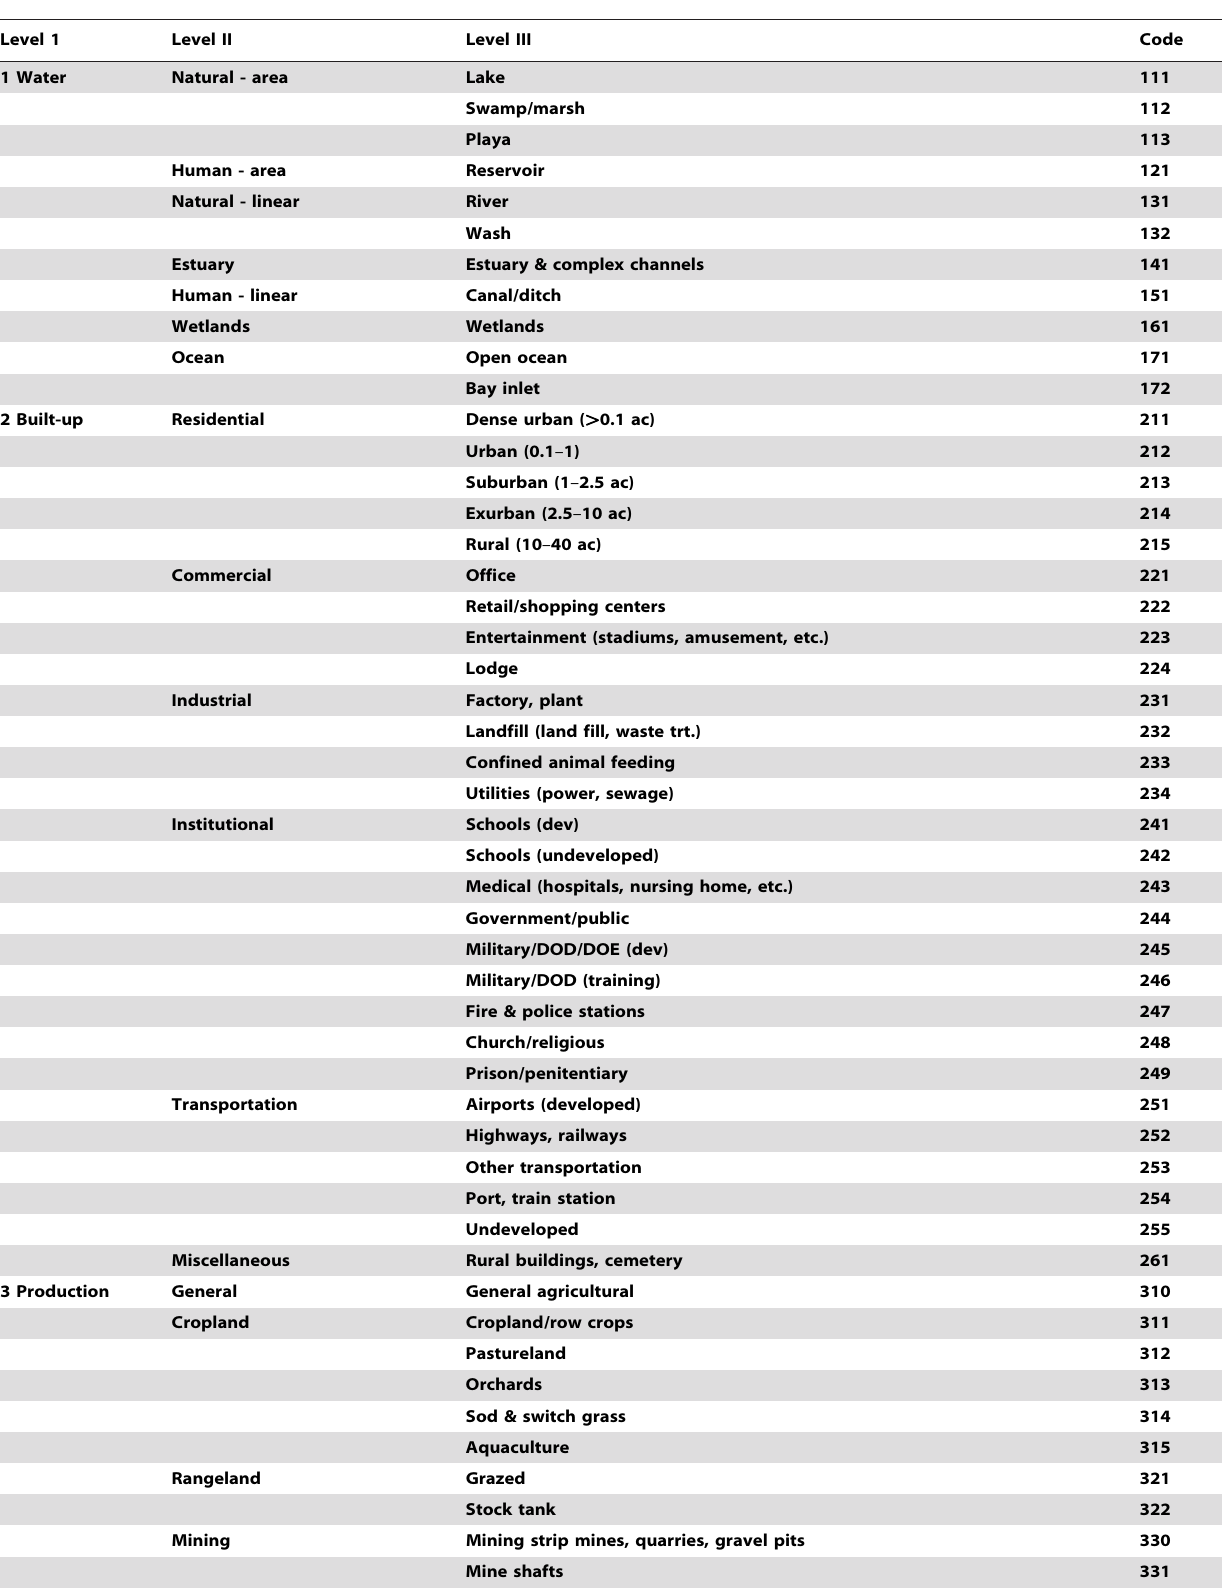
Table 1. A multi-purpose, hierarchical land use classification